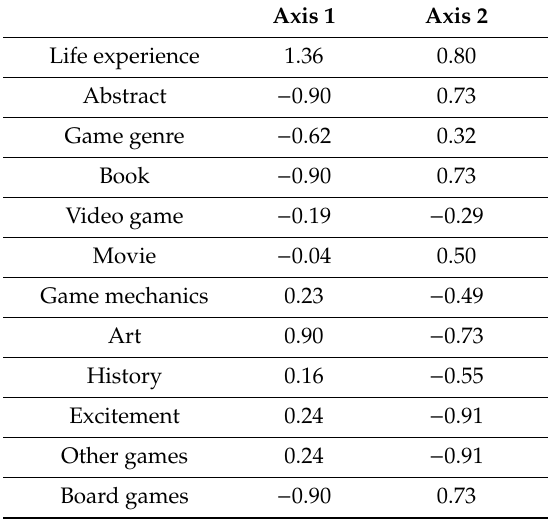
Table 3. Column of education and source of inspiration.